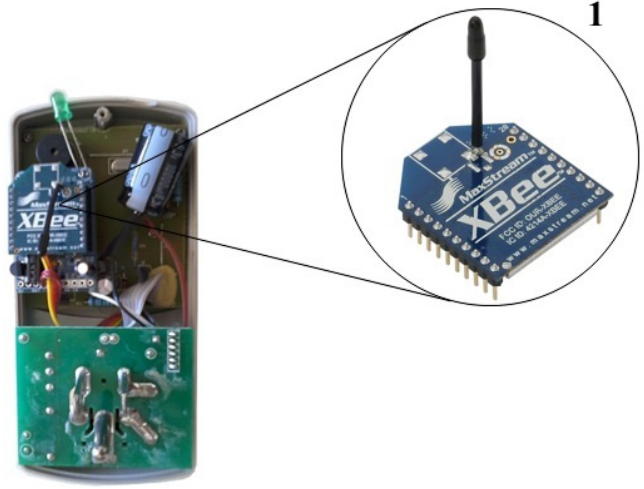
Figure 2. Wattmeter developed with XBee wireless communication for the formation of the